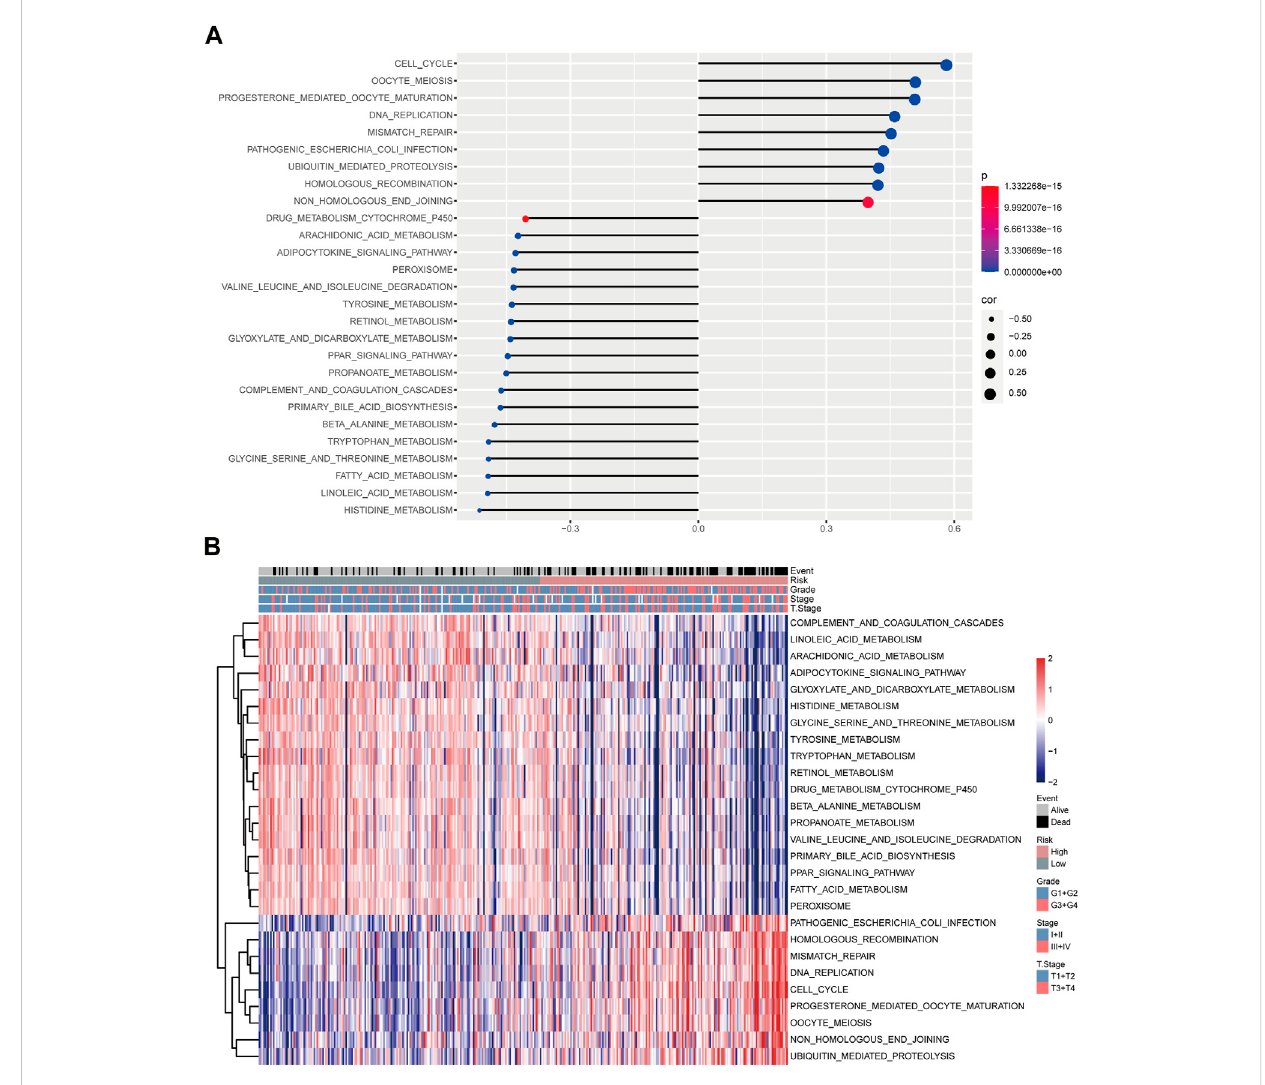
FIGURE 6 Potential regulatory pathwaysof therisk model. (A) Correlation analyses betweenrisk score and enriched pathways. (B) Distribution of the enriched pathways in high- and low-risk groups are shown in the Heatmap.